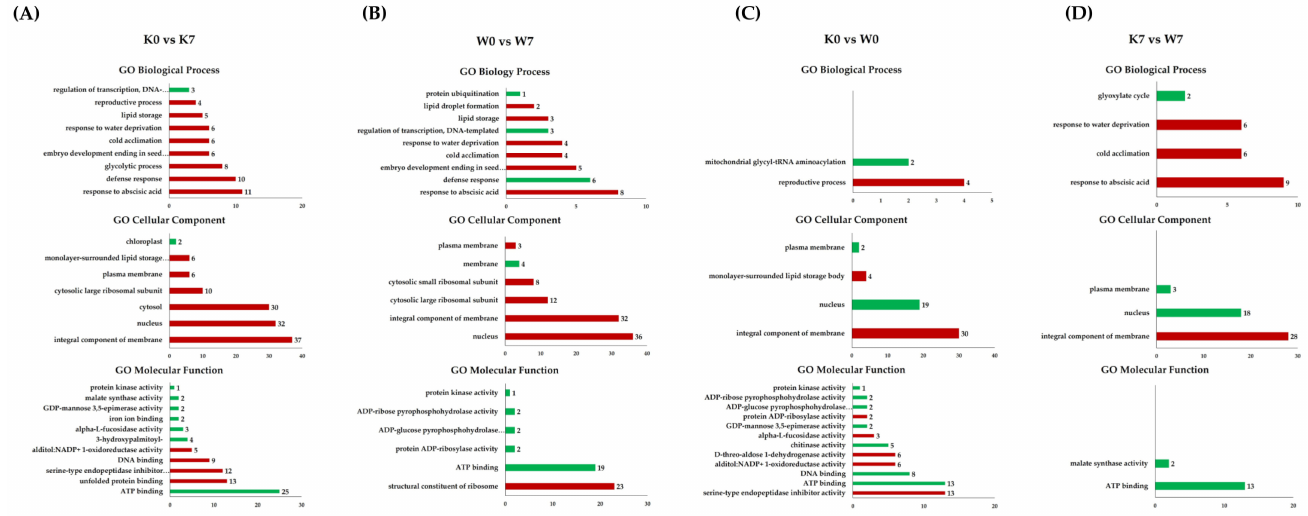
Figure 6. Gene Ontology comparisons with respect to cultivars and duration of PHS treatment in proteome analysis. GO analysis was performed on DEPs identified in the K0 vs. K7, W0 vs. W7, K0 vs. W0, and K7 vs. W7 groups, and GO terms belonging to the categories of biological processes, cellular components, and molecular functions are indicated. The upregulated (red) and downregulated (green) terms were divided by group. The X -axis represents the number of annotated DEPs, and the Y -axis lists GO functions by category. The number of GOs performed with DEPs was comparatively smaller than that of the GOs performed with DEGs, and so both the up- and downregulated entries are displayed in one graph. ( A ) Annotated GO terms in K0 vs. K7, ( B ) annotated GO terms in W0 vs. W7, ( C ) annotated GO terms in K0 vs. W0, and ( D ) annotated GO terms in K7 vs. W7.